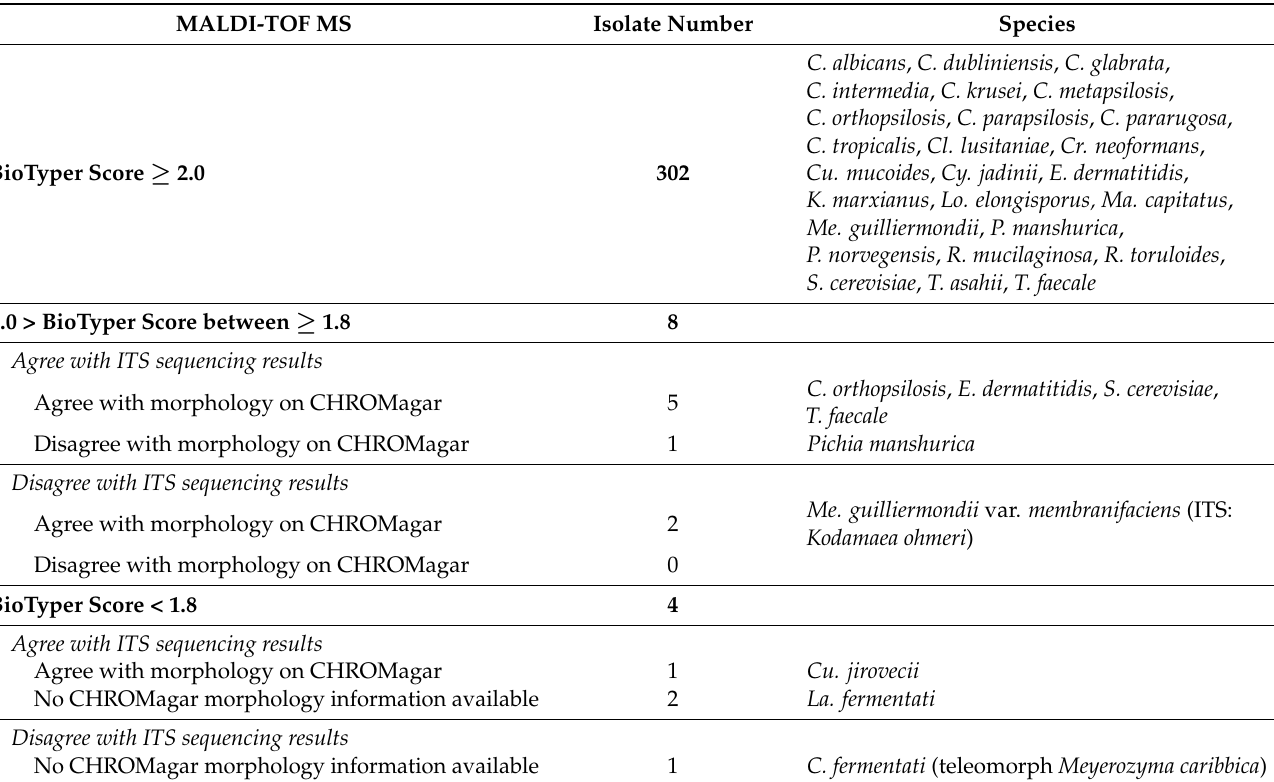
Table 2. Oral yeasts in the residents of nursing